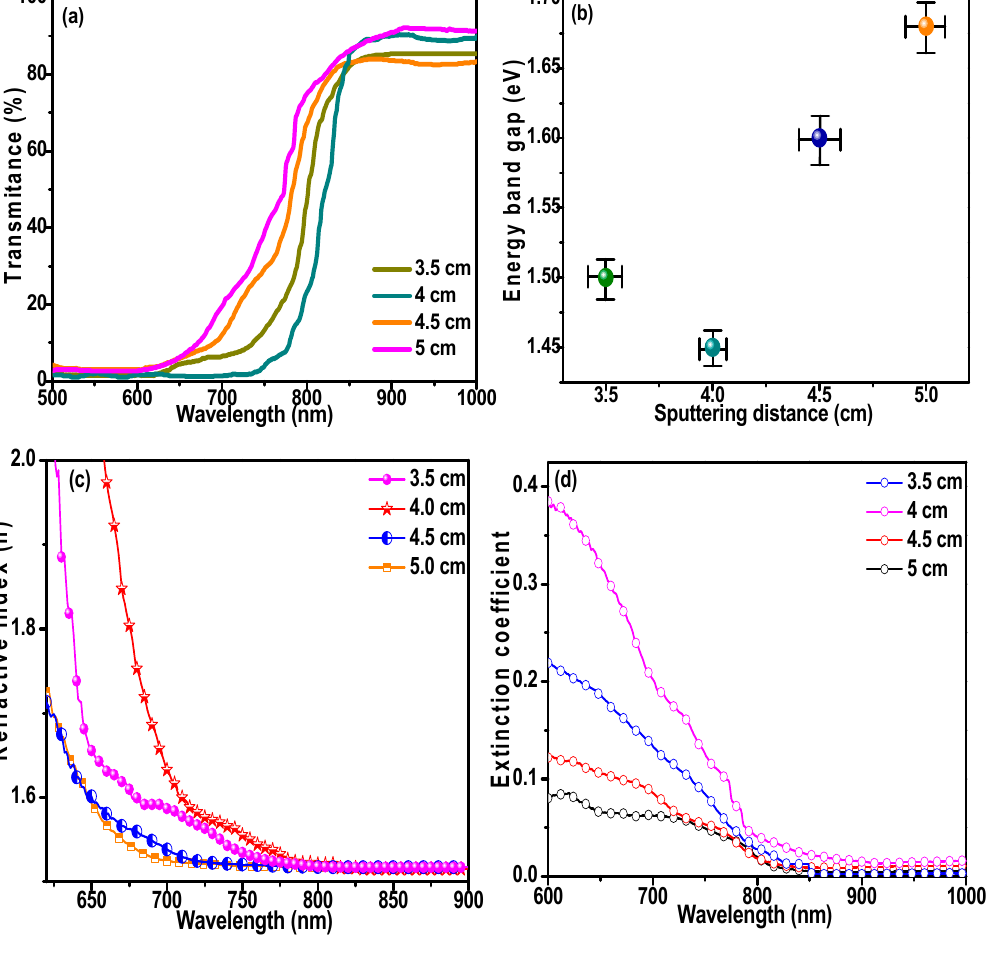
Figure 7. Optical properties of CdTe films prepared at different substrate-target distances. ( a ) Transmission spectrum; ( b ) energy band gap; ( c ) refractive index (n); and ( d ) extinction coefficient.